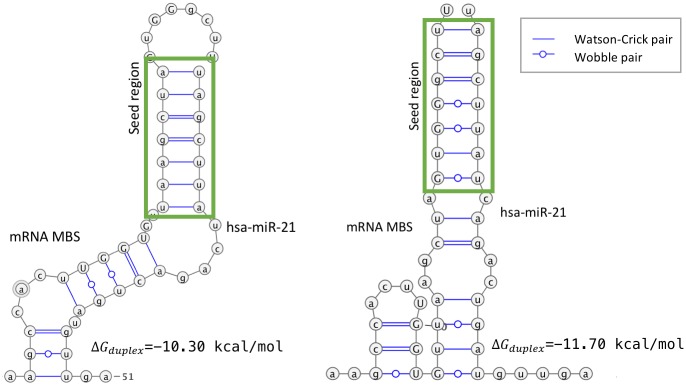
Example of a miRNA binding site that can accommodate a miRNA (hsa-miR-21) with different binding patterns and different site stabilities.The left figure shows a canonical binding (perfect 7mer) with ΔGduplex = −10.30kcal/mol while the right figure shows a non-canonical binding (containing wobbles in the seed region) ΔGduplex = −11.70kcal/mol. While the left structure can be identified by both canonical and non-canonical CSSMs, a non-canonical CSSM will preferentially select the right hand structure as a potential MBS since it reports a more stable predicted binding energy.